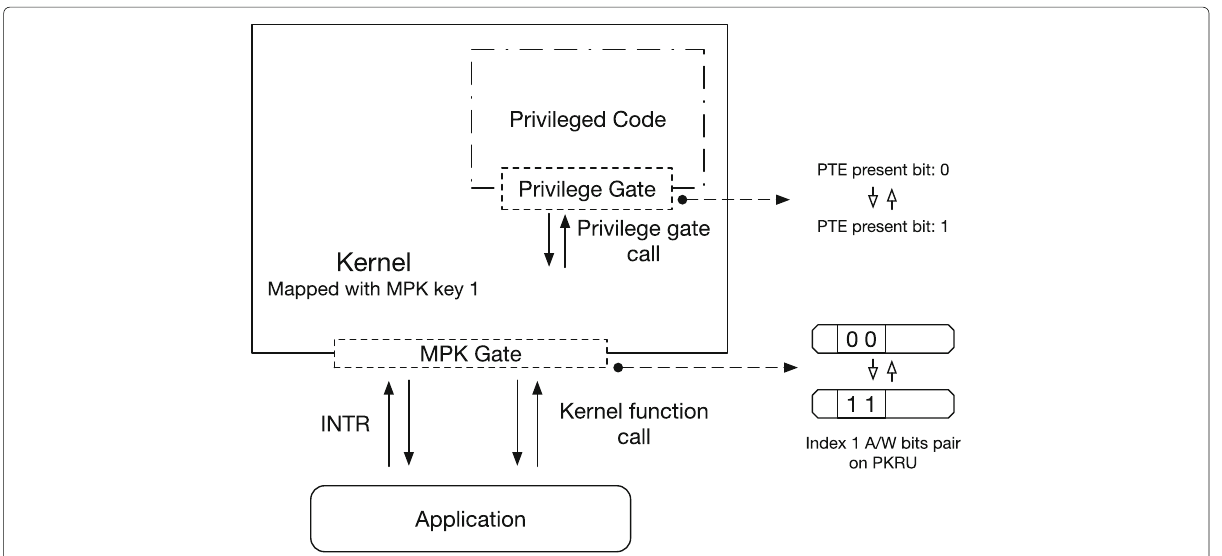
Fig. 4 Two Gates design. “P” means present bit, “U” means user bit in page table